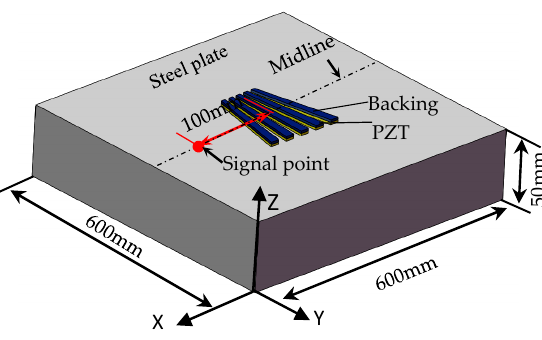
Figure 7. Simulation model of non-equidistant comb transducer. Table 1. Material parameters for simulation.